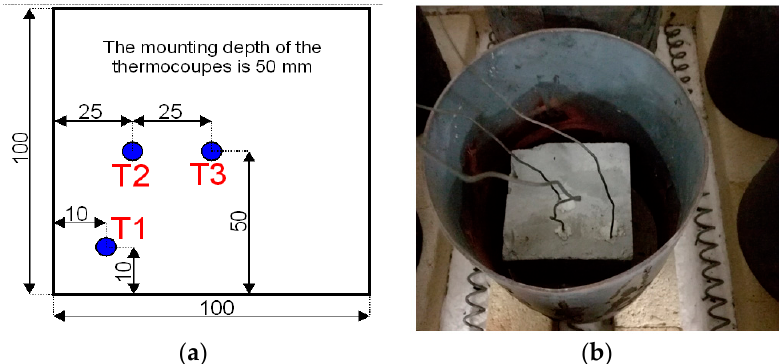
Figure 1. View of cubic sample: ( a ) Layout of thermocouples; ( b ) View of a sample with measuring thermocouples.